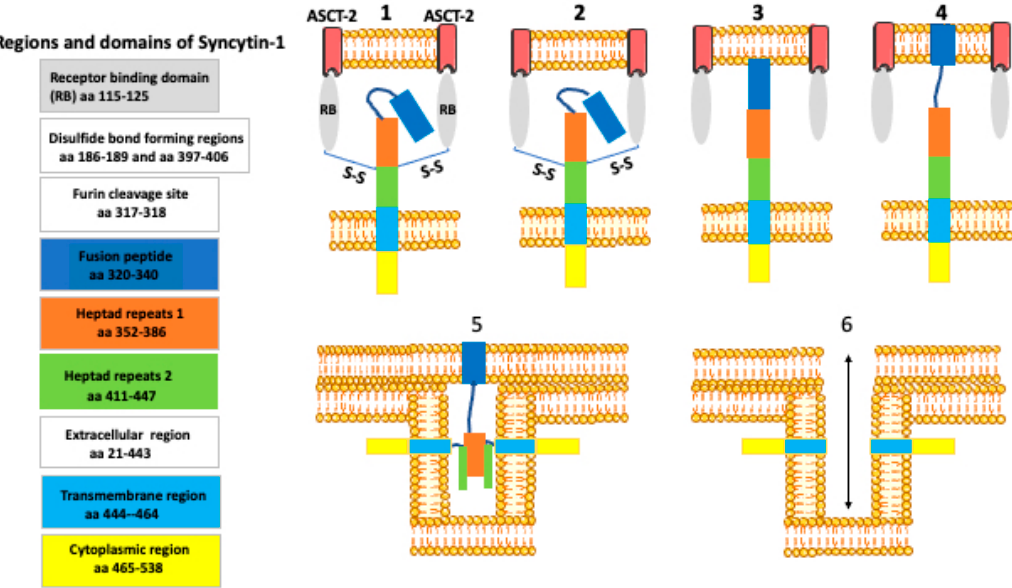
Figure 1. The main regions and domains of syncytin-1 and its conformational transformation during the membrane fusion. The left panel shows the main domains (marked in different colors) of the syncytin-1 molecule. The right panel shows six consecutive steps of syncytin-1 molecule transfor- mation during membrane fusion. The membrane layers depicted in the drawings belong to two different fusing cells. The colors of the syncytin-1 molecule correspond to those shown in the left panel. The binding of the receptor-binding domains (RBs) to the receptor (ASCT-2) breaks the disulfide bonds and unfolds the fusion peptide that becomes inserted into the membrane. This is followed by the positional changes of heptad repeats -1 and -2 domains. The final steps consist of membrane apposition and bending (adapted from